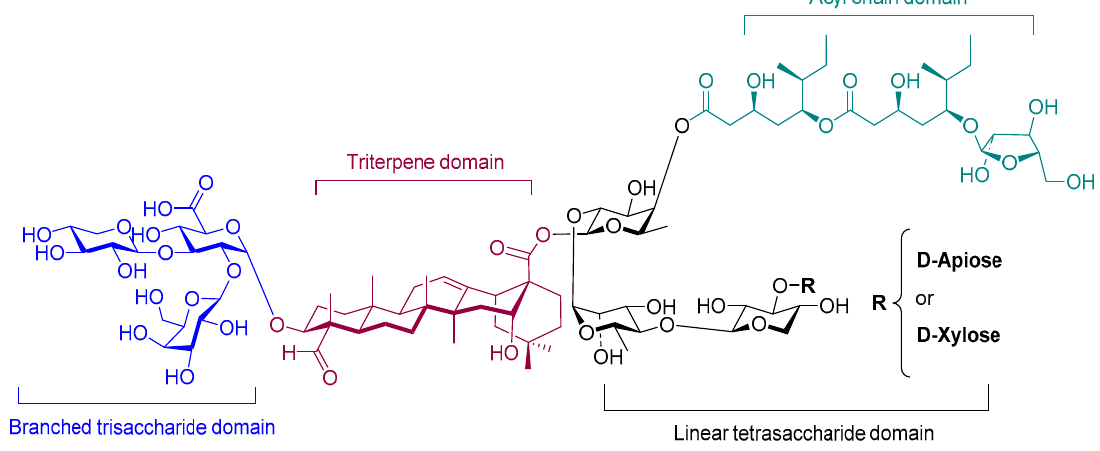
Figure 8. Example of saponin (QS-21) with the four major typical structural domains.